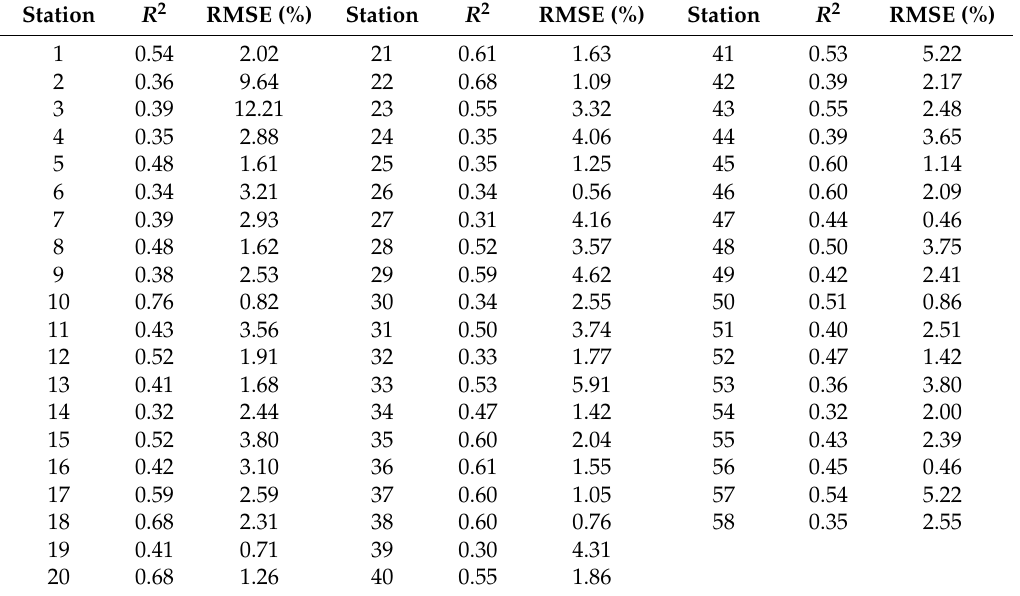
Table 6. Summary of the average (2013–2015) R 2 and root mean square error (RMSE) values at 58 soil moisture